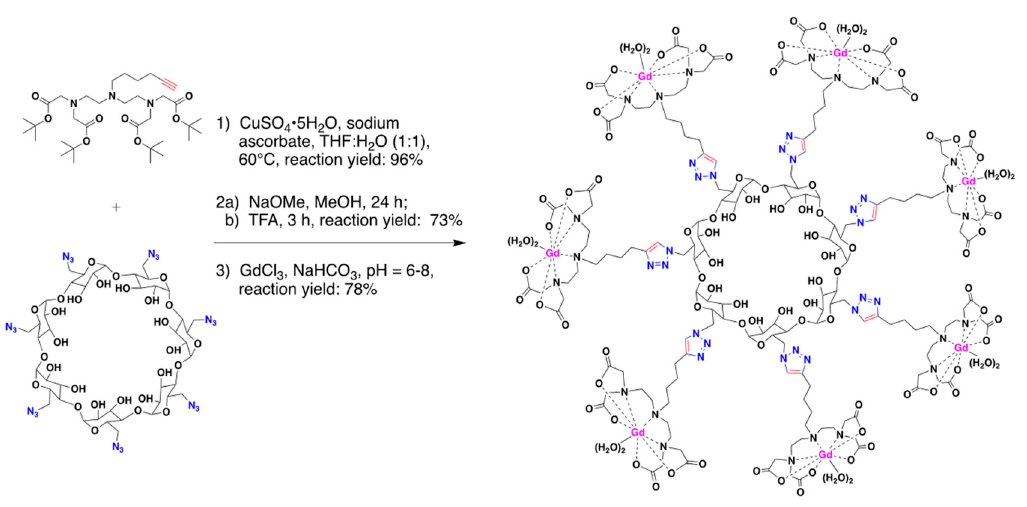
Figure 4. Multivalent β -CD “Click cluster”, containing seven paramagnetic chelating groups, each with two water exchange sites linked via triazole-based linkers. The β -CD “Click cluster” was synthesized from per-azido- β -CD precursor and conjugated using the well-established Huigsen cycloaddition reaction. Figure adapted from Bryson et al. with permission from publisher [35].